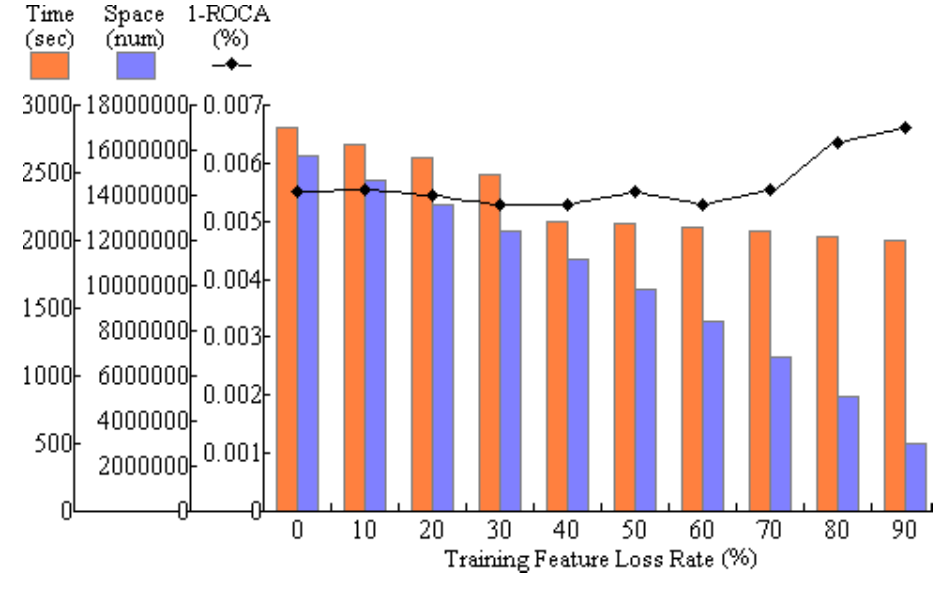
Fig. 7. Time, Space and 1-ROCA Performance under Different Training Feature Loss